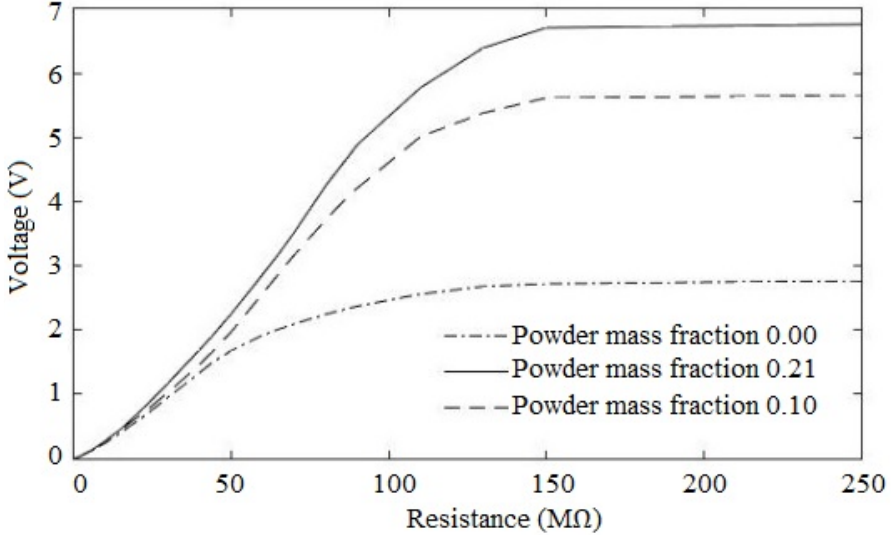
Figure 13. Peak voltage variation with the hair powder mass fraction.